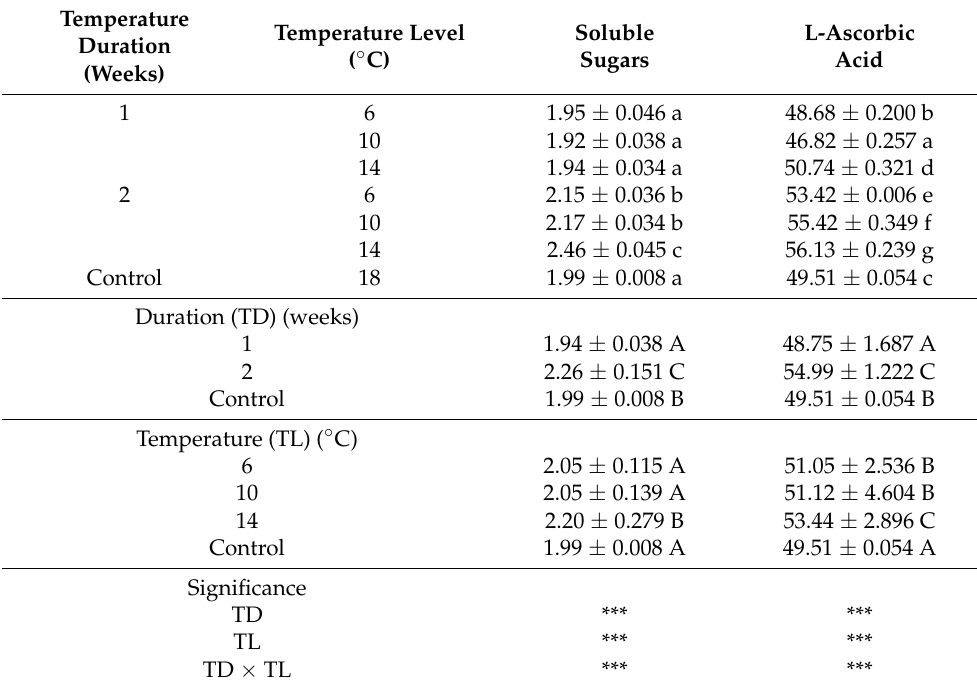
Table 3. Effect of low-temperature treatment of the seedlings on soluble sugars (g 100 g − 1 FW)